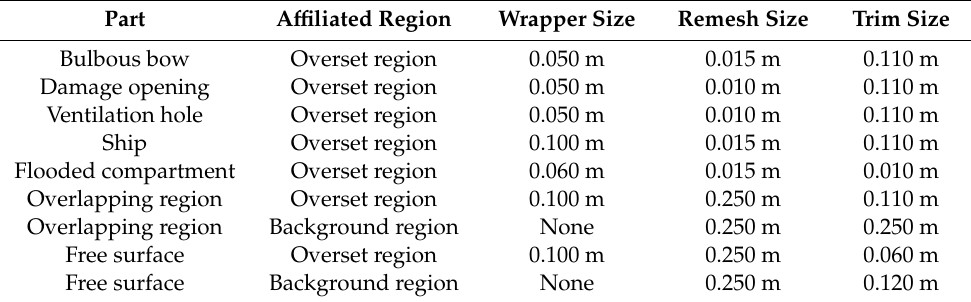
Figure 9. Visualization of the hexahedral mesh. Table 5. Mesh sizes in di ff erent